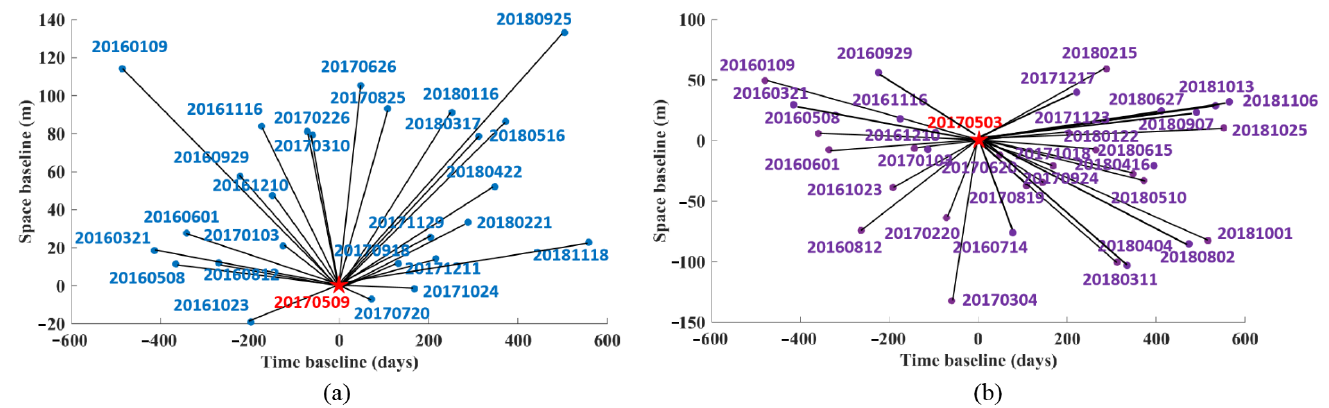
Figure 4. Temporal and spatial baselines of SAR datasets, ( a ) ascending track and ( b ) descend- ing